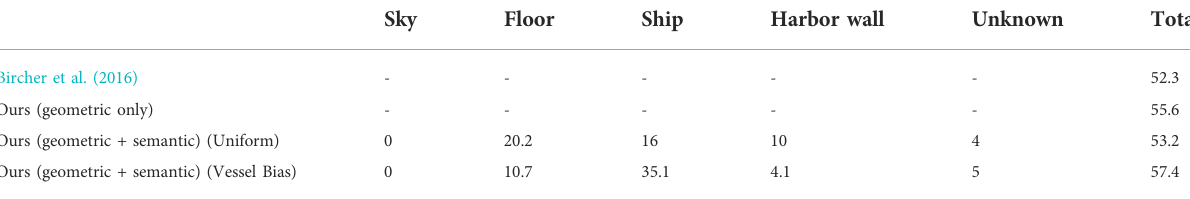
TABLE 5 Average mapping computational times (ms) per iteration step.